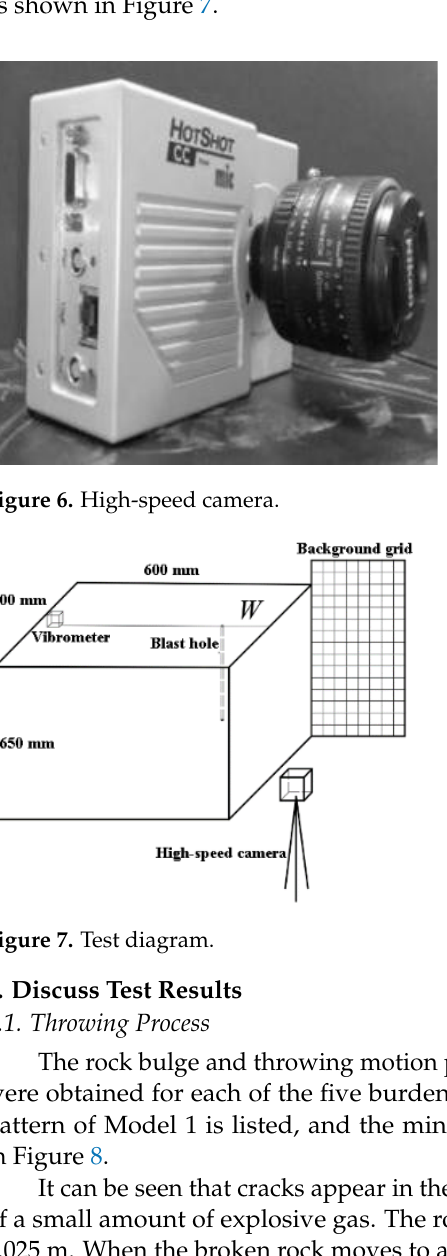
t = 20 ms Figure 8. Space position of rock at different time.